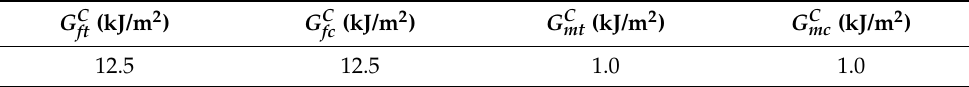
Table 5. Fracture energies for fibre and matrix tension and compression failure modes for S2-FM94 glass fibre adhesive